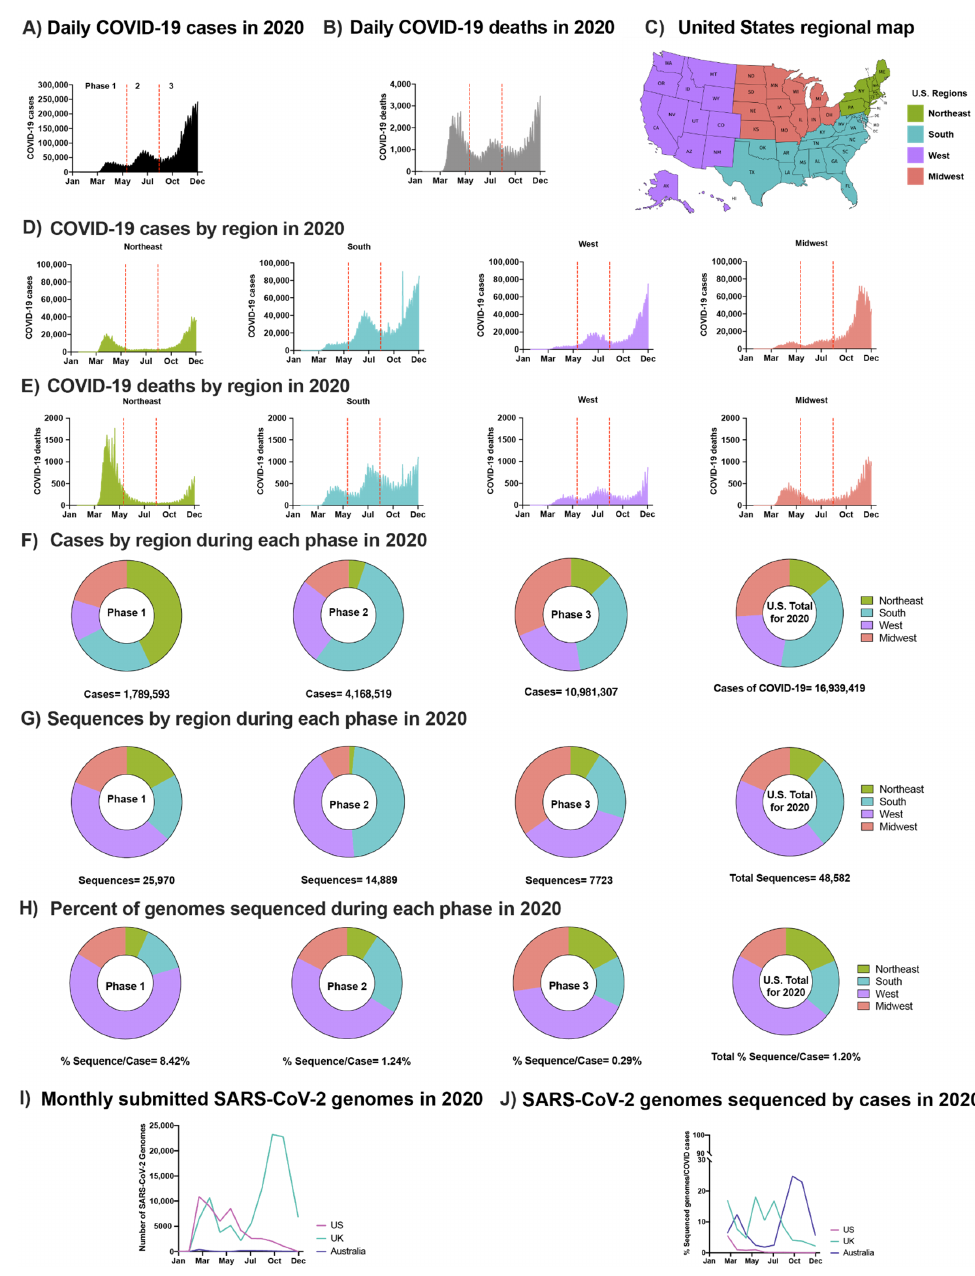
Figure 1. SARS-CoV-2 epidemic in the U.S. in 2020: ( A ) Daily COVID-19 cases in the U.S. in 2020. ( B ) Daily COVID-19 deaths in the U.S. in 2020. ( C ) U.S. regional map colored by region. ( D ) Number of COVID-19 cases in the U.S. in 2020 by region: Northeast, South, West, Midwest, respectively. ( E ) Number of COVID-19 deaths in the U.S. in 2020 by region. ( A , B ) and ( D , E ) Separation of phases is denoted by vertical dotted red lines. Data were smoothed by a moving 3-day average. ( F ) Proportion of COVID-19 cases by region during each phase and the overall contribution to the U.S. total in 2020. ( G ) Proportion of SARS-CoV-2 sequences accessed (submission as of 15 December 2020) by region during each phase and the overall contribution to the U.S. total in 2020 ( H ) The number of sequences per case were obtained by each region during each phase and the U.S. total in 2020. ( F – H ) Highlights Phases 1, 2, and 3, followed with U.S. total of 2020. ( I ) Total number of sequences submitted to GISAID from the U.K., Australia, and the U.S. by 15 December 2020. ( J ) Submitted SARS-CoV-2 genomes normalized to the number of COVID-19 cases from the U.K., Australia, and the U.S. (see Section